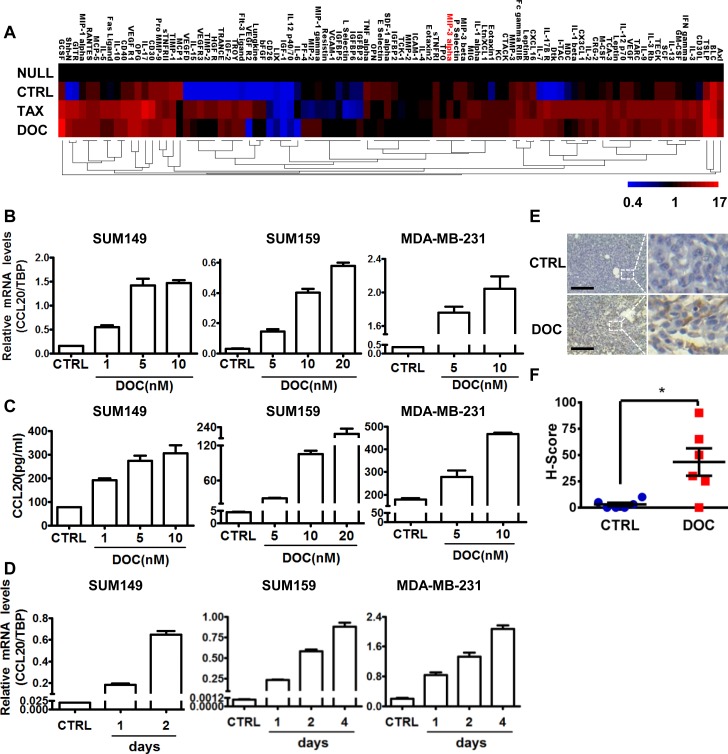
CCL20 was induced by taxanes significantly both in vitro and in vivo.(A) Sera from wild-type BALB/c (“NULL”), 4T1 tumor-bearing BALB/c mice (1 × 105 4T1 cells were injected per site of fourth mammary fat pads) without chemotherapy (CTRL) or with TAX (10 mg/kg) or DOC (10 mg/kg) i.p. once a week (the treatment was started when the average tumor size reached 2 mm in diameter). Five mice per group. After 4-week treatment, mouse cytokine antibody array was carried out with the collected sera from each group of mice, and a heat map was presented with the average cytokine levels (fold change over NULL group) of duplicates clustered with hierarchical maximum linkage and similarity metric of euclidean distance. CCL20 (MIP-3 alpha) is marked in red. (B) SUM149, SUM159, and MDA-MB-231 (MDA-231) cells were treated with the indicated concentrations of DOC for 3 days; then, qRT-PCR was performed to determine the mRNA levels of CCL20 in triplicates. (C) ELISA was carried out with 2-day FBS-free conditioned medium after treatment with the indicated concentrations of DOC for 3 days in SUM149, SUM159, and MDA-MB-231 cells. Bar graphs are representative of duplicated experiments of ELISA and 3 repeats in each experiment. (D) Breast cancer cells were treated with DOC (1 nM for SUM149, 5 nM for SUM159, 14.1 nM for MDA-MB-231) for the indicated days; then, qRT-PCR was performed to determine the mRNA levels of CCL20 in triplicates. (E) CCL20 expression was determined by IHC in the tumor sections of MDA-MB-231 xenografts (1.5 × 106 MDA-MB-231 cells were injected per site of fourth mammary fat pads of nude mice) without (CTRL) or with DOC administration (10 mg/kg, i.p.) once a week for a total 5 weeks. Scale bars: 200 μm. (F) H-Scores of CCL20 levels in (E) were presented as scatter diagram. *p < 0.05 by unpaired t test. Tumor numbers n = 6 per group. Data of bar graphs were shown as mean ± SEM. CCL20, C-C motif chemokine ligand 20; CTRL, control; DOC, docetaxel; ELISA, enzyme-linked immunosorbent assay; FBS, fetal bovine serum; H-Score, histo-score; i.p., intraperitoneally; MIP-3 alpha; macrophage inflammatory protein 3 alpha; qRT-PCR, quantitative real-time PCR; TAX, taxol; TBP, TATA-box binding protein.